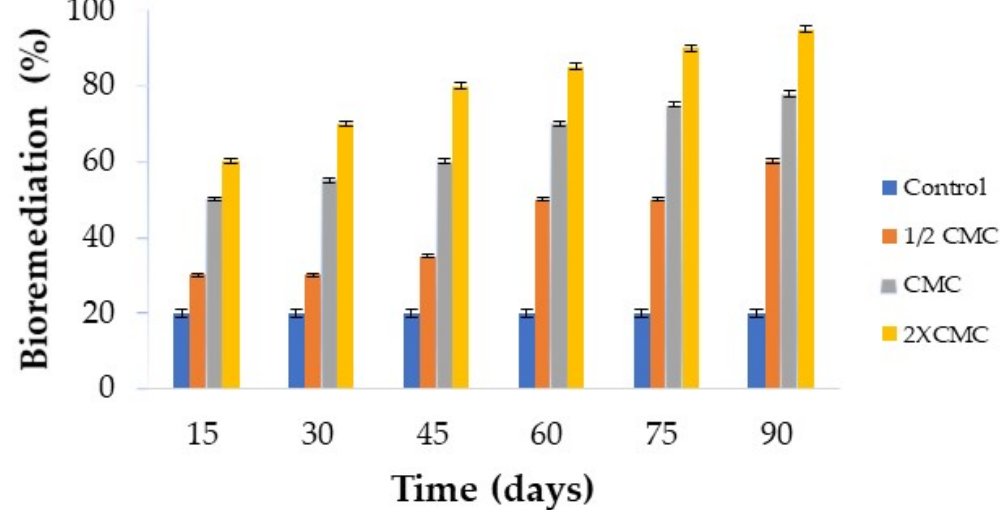
Figure 10. Percentage removal of oil adsorbed to sand by biodegradation using the biosurfactant produced by Candida sphaerica.